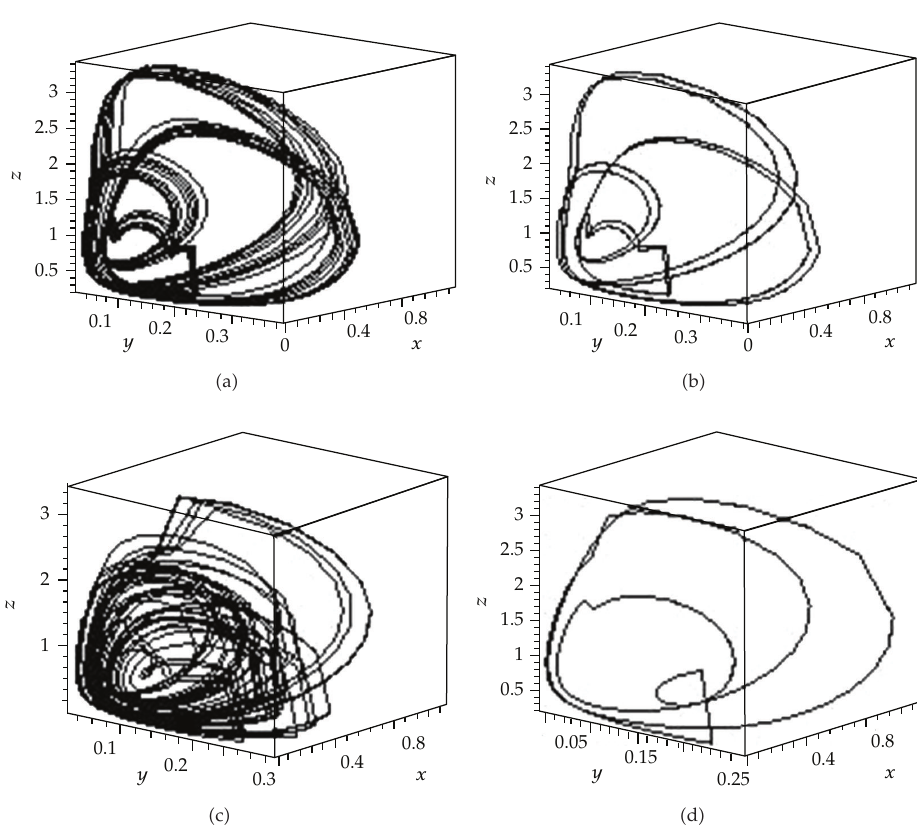
Figure 3: Crisis. (cid:5) a (cid:6) Chaotic attractor when p (cid:7) 0.88, (cid:5) b (cid:6) phase diagram of periodic solution when p (cid:7) 0.9, (cid:5) c (cid:6) chaotic attractor when p (cid:7) 1, and (cid:5) d (cid:6) phase diagram of periodic solution when p (cid:7)